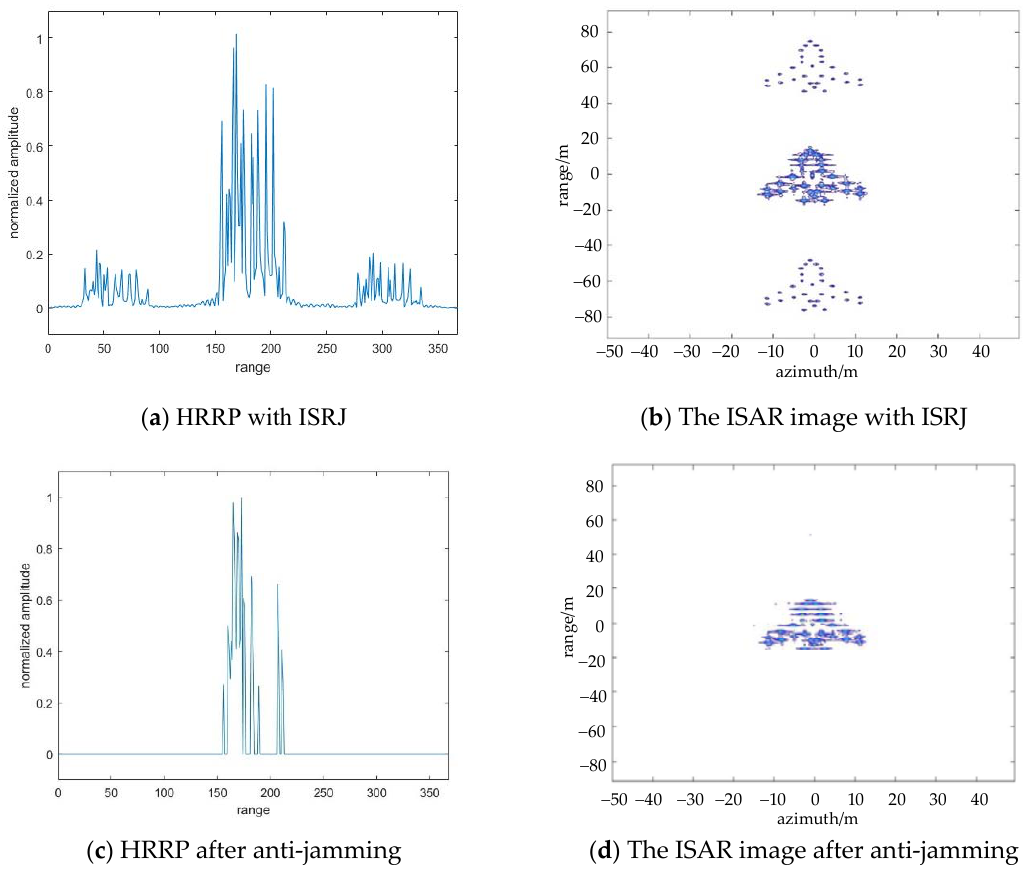
Figure 5. The results of ISRJ jamming and anti ‐ jamming in the fast time domain, when M d = 29, M a = 32. Next, the anti ‐ interference of the algorithm against azimuth ISRJ interference is sim ‐ ulated. Figure 6a,c shows the azimuth profile and ISAR image with ISRJ in the slow time domain. Figure 6b,d are the results after anti ‐ jamming . At this time, the calculated num ‐ ber of measurements in the range direction and azimuth direction is ， is effectively suppressed the ISRJ signal that only the middle target is retained and false targets next to the middle targets are removed.